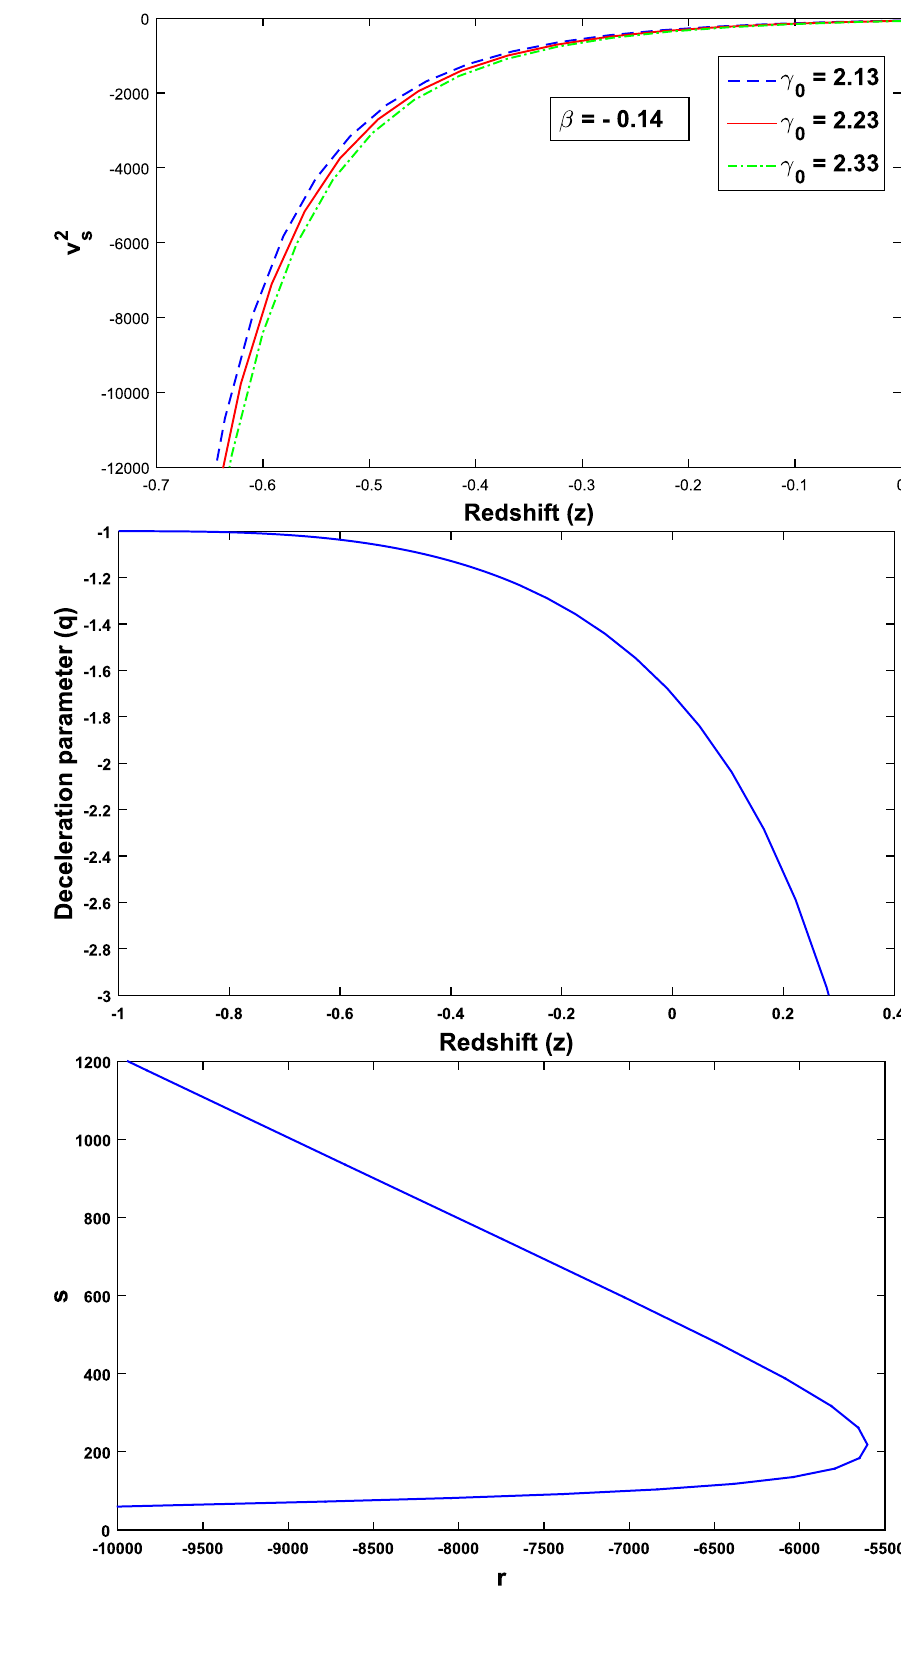
Fig. 15 Plot of squared sound speed ( v 2 s ) versus redshift ( z ) for c 1 = 0 . 01, c 2 = 0 . 115, k = 0 . 325, γ = 2 . 13 , 2 . 23 , 2 . 33, α = 1 . 5, 0 and β = − 0 . 14